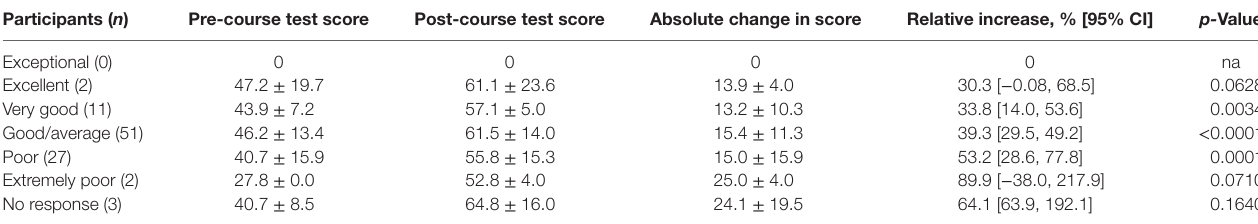
TaBle 4 | Change in scores from pre-course to post-course questionnaire by level of clinical research knowledge, participant reported.